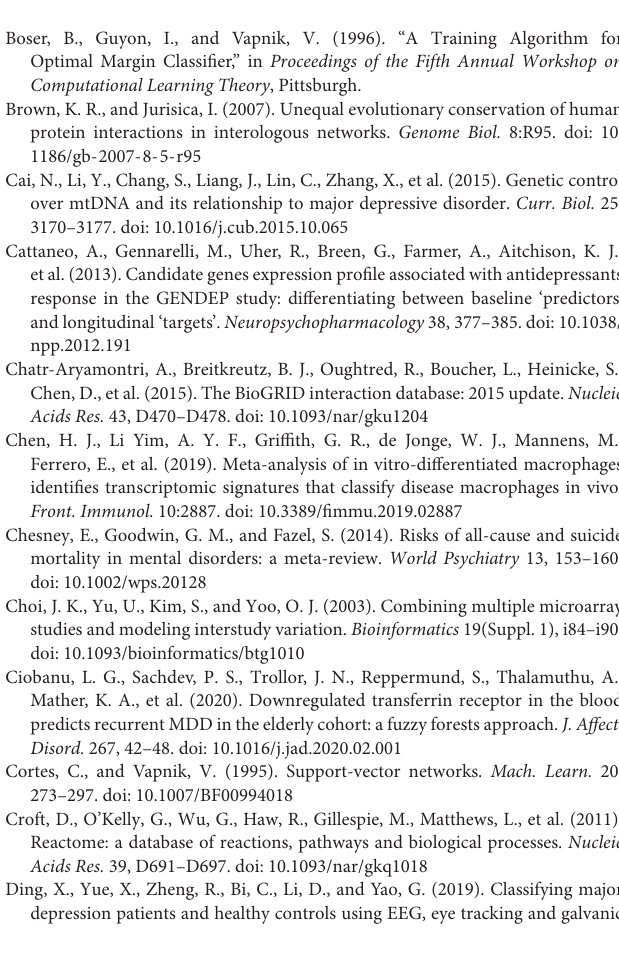
Supplementary Figure 1 | Quality control results of merged datasets from eight microarray profiles. SMR, standardized mean rank. Supplementary Figure 2 | Biological functional of protein–protein interaction network constructed using MDD-related DEGs. (A) Functional interaction (FI) network. Node sizes represent p -values of FI network, large for low value and small for high. Node colors define mean effect size in MDD-related DEGs, ranging from red for high expression to blue for low expression. (B) Five generated network modules incorporate 26 genes, which are shown in different colors in network modules. (C) Correlation heat map of genes in different modules. Supplementary Figure 3 | Workflow of machine learning. TP, true positive; TN, true negative; FP, false positive; FN, false negative. Supplementary Figure 4 | (A) The accuracy of gene selection procedure using RF. (B) Average AUC when modeling with different numbers of features. (C) ROC in model parameter calculation procedure using SVM. Supplementary Figure 5 | Clustering heatmap of feature genes and samples in training dataset. Color gradient from purple to red represents changes in expression from low to high. Bars represent samples (orange refers to MDD samples, blue to control